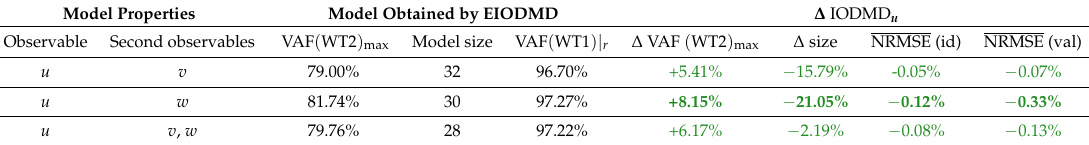
Table 4. Models validation results using the EIODMD algorithm with different observables. The second observables column has the state chosen to augment the initial data matrix with u information. The last two columns represent the average NRMSE of the first observable, using both identification and validation